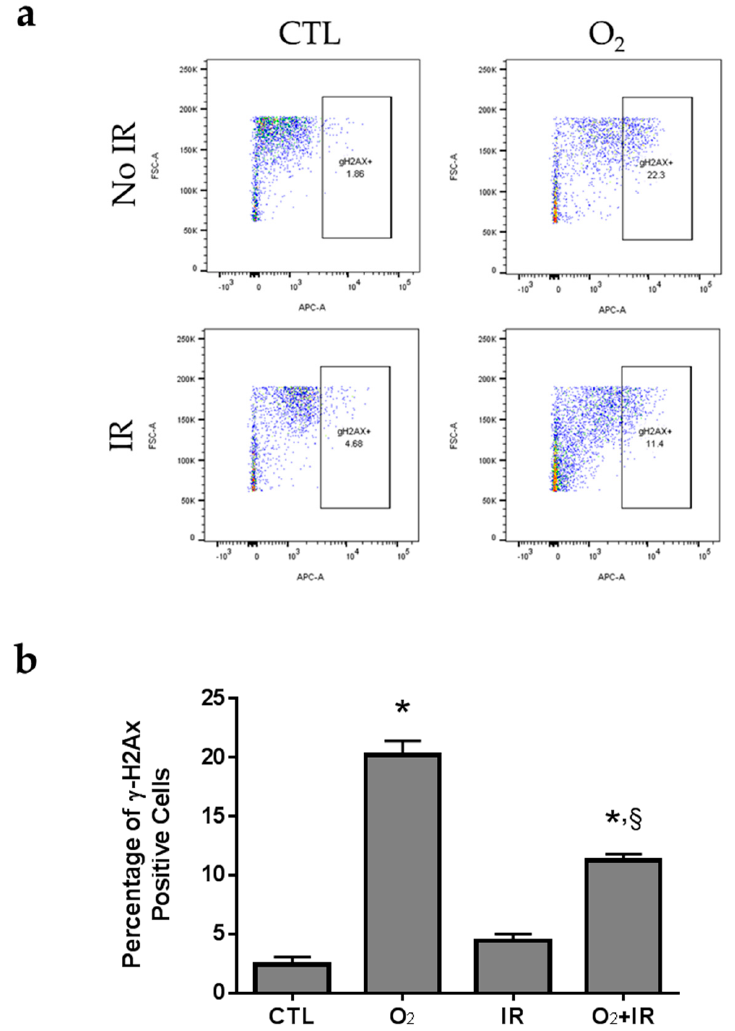
Figure 6. Flow cytometric analysis of H2AX phosphorylation in lung epithelial cells 48 h (2 cycles) after exposure to hyperoxia, radiation, and double-hit combination challenge. Non-tumorigenic murine alveolar type II epithelial cells (C10) were evaluated after 2 cycles of hyperoxia and radiation exposure and evaluated by flow cytometric analysis of γ H2AX and PI. ( a ) Representative flow cytograms depicting anti- γ H2AX (Serine 139) labeling of cells under hyperoxic conditions and IR; ( b ) Levels of H2AX phosphorylation represented by the percentages (%) of positive stained C10 cells in every cohort. Data are represented as the mean ± SEM. * p < 0.05 for each exposure condition as it compares with the unexposed control (CTL); § p < 0.05 for significant differences between IR-alone compared to O 2 + IR.